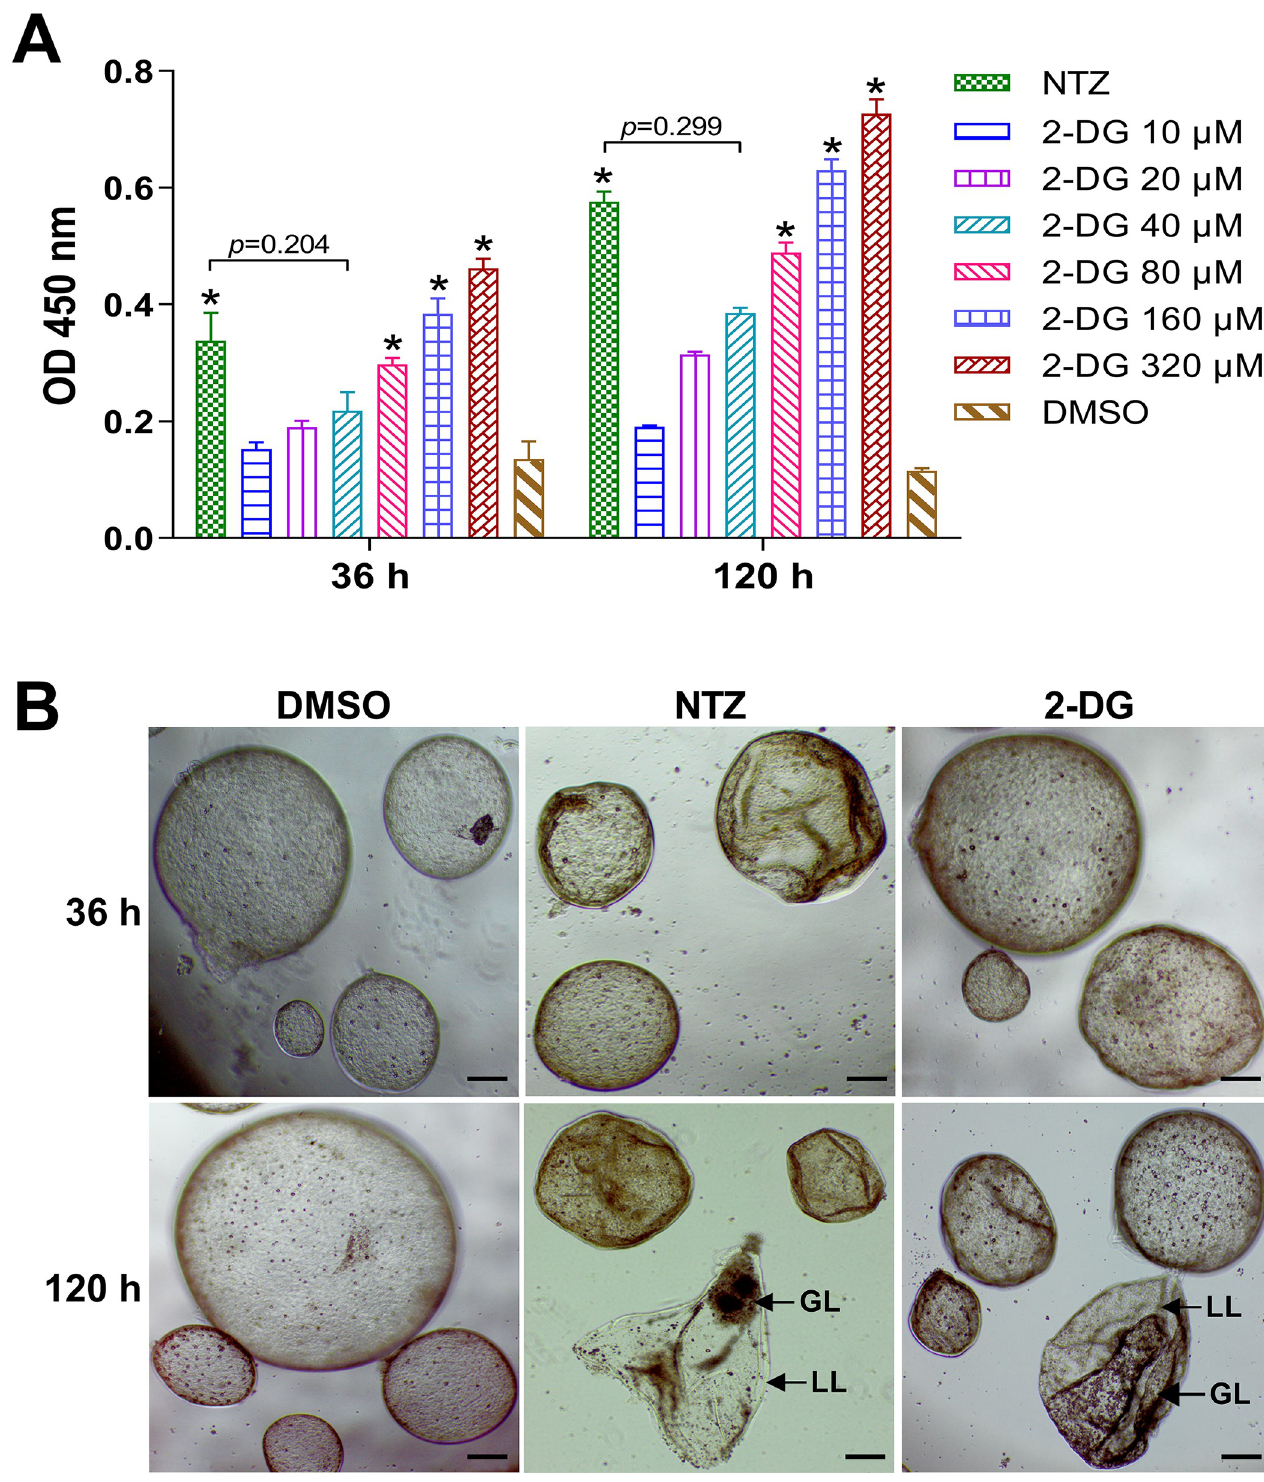
Fig 2. In vitro effects of 2-DG on E . multilocularis metacestodes. (A) E . multilocularis AP ( Em AP) activities in the medium supernatant after 36 and 120 hours of treatment with 40 μ M NTZ or various 2-DG concentrations (10, 20, 40, 80, 160, and 320 μ M). Vesicles incubated in the culture medium containing DMSO served as controls. � p < 0.05 vs. DMSO control. (B) Microscopical damage to metacestodes treated with 40 μ M NTZ or 40 μ M 2-DG for 36 and 120 hours. Control vesicles exhibited no morphological changes, while drug-treated vesicles showed increased collapse and wrinkled cyst walls. LL, laminated layer; GL, germinal layer. Scale bar, 200 μ m. https://doi.org/10.1371/journal.pntd.0010618.g002 PLOS NeglectedTropical Diseases | https://doi.org/10.1371/journal.pntd.0010618 July 18,